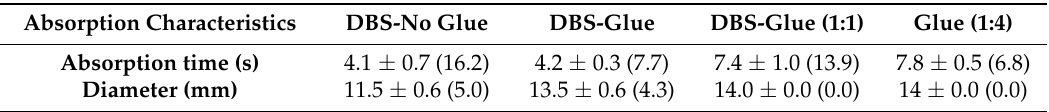
Table 2. Absorption time and absorption diameter for dried blood spots (DBSs) prepared in the presence and absence of glue. Please check and